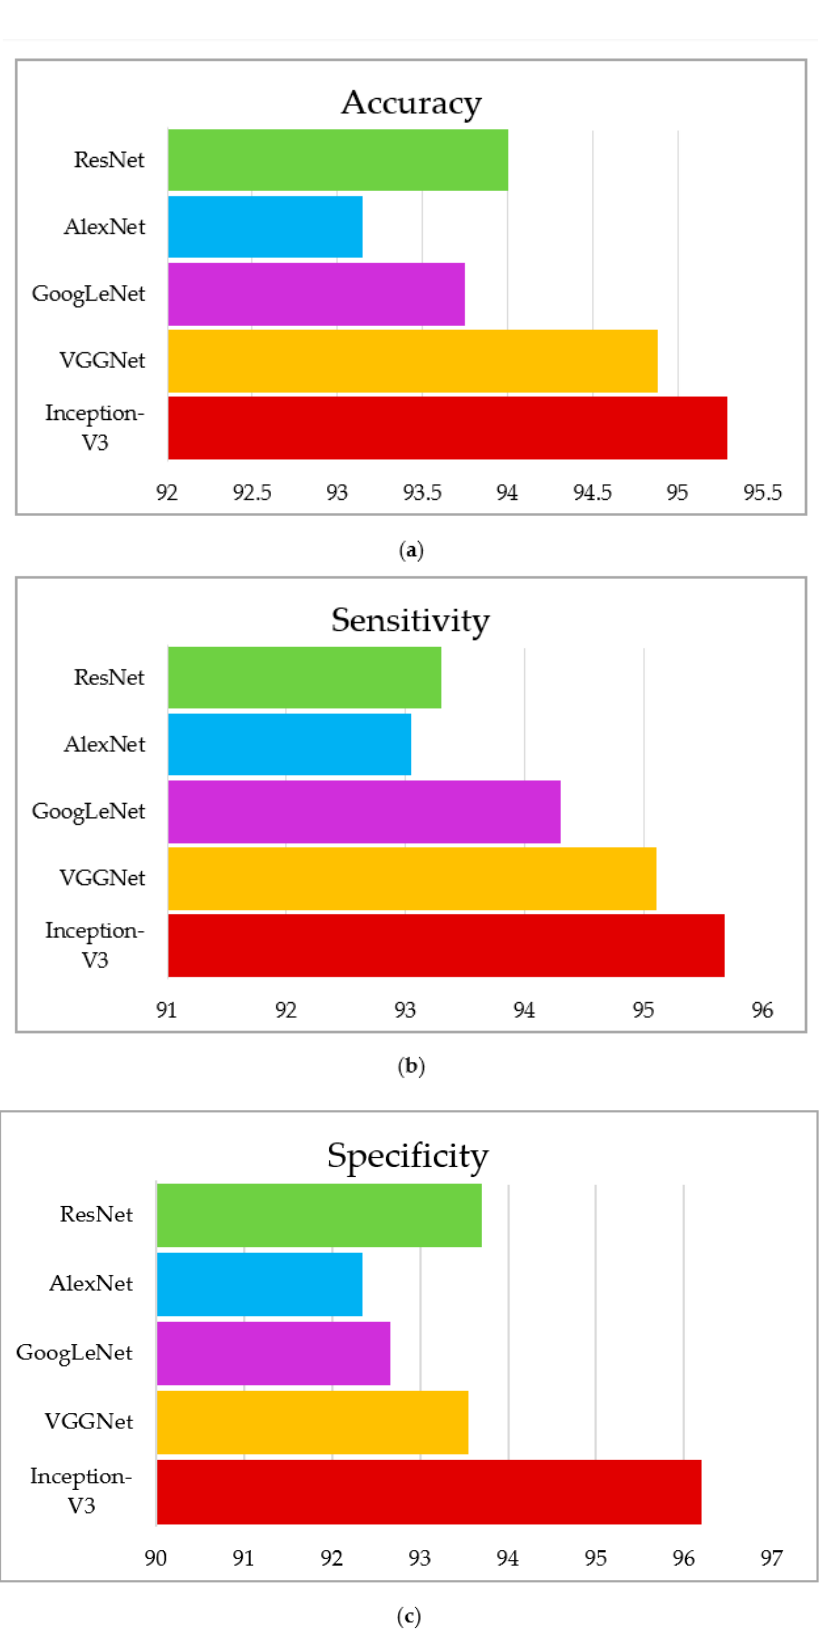
Figure 13. Graphical representation of GWO- IV3, ( a ) accuracy, ( b ) sensitivity, ( c ) specificity.